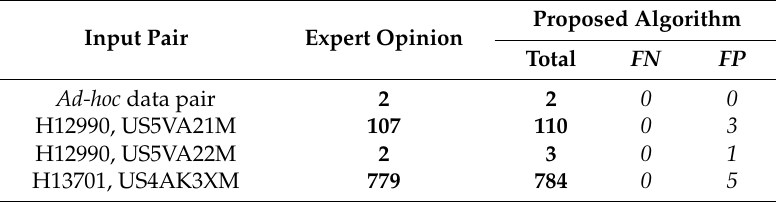
Table 7. Results for chart discrepancies using the proposed algorithm. The Expert Opinion column provides the total number of chart discrepancies used to identify the false negatives (FN) and the false positives (FP) for the automated